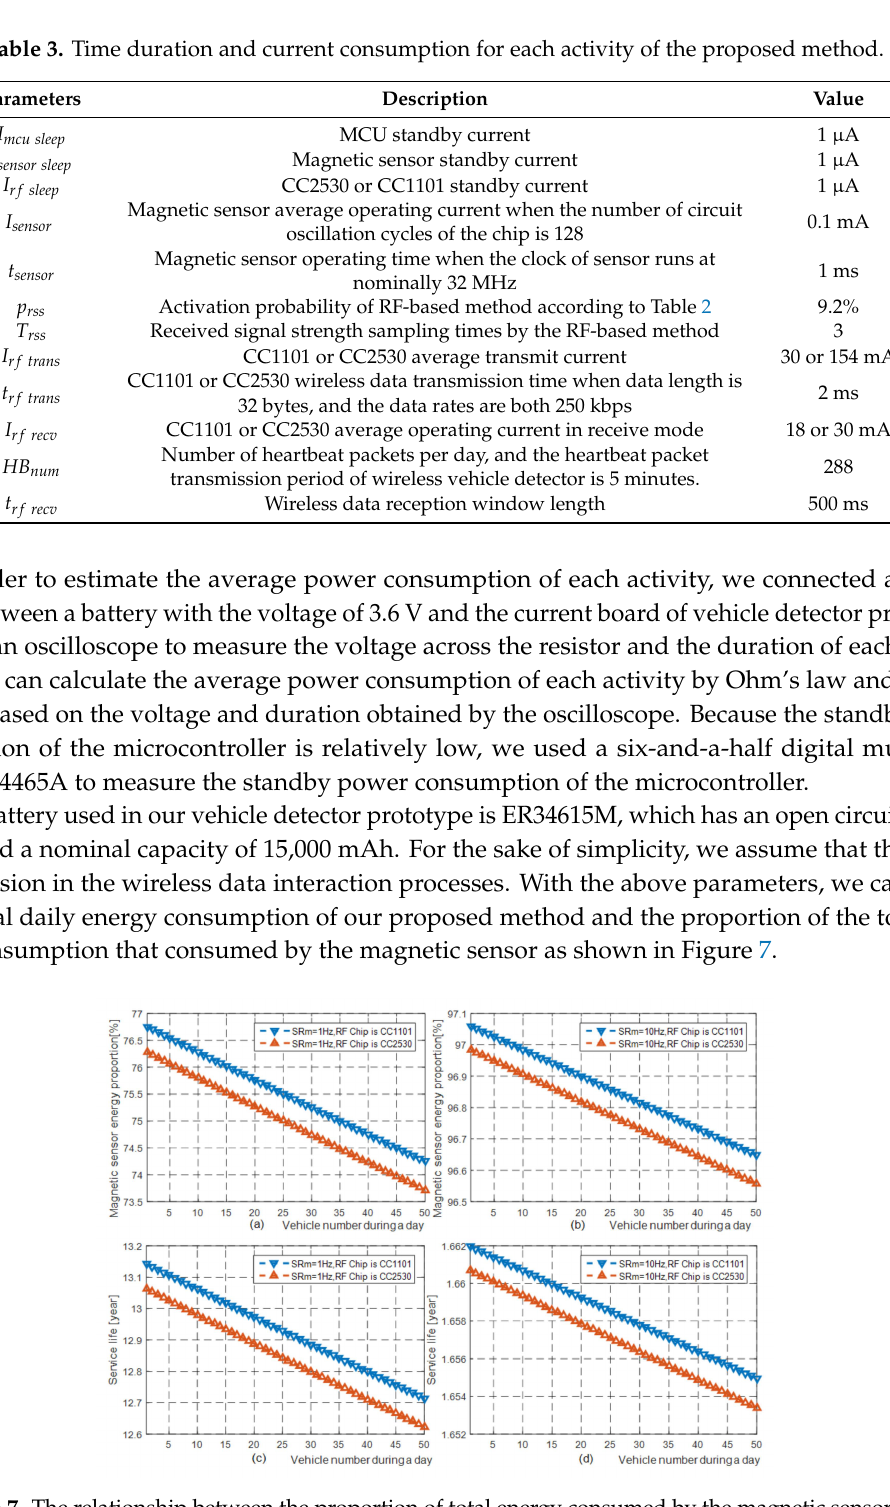
Figure 7. The relationship between the proportion of total energy consumed by the magnetic sensor and the number of vehicles detected per day, and the relationship between the WVD service years and the number of vehicles detected per day. ( a ) The proportion of the total energy consumed by the magnetic sensor in the two WVD prototypes with the radio frequency of 433 MHz and 2.4 GHz when the sampling rate of the magnetic sensor is 1 Hz. ( b ) The proportion of the total energy consumed by the magnetic sensor in the two WVD prototypes when the sampling rate of the magnetic sensor is 10 Hz. ( c ) The nominal serviceable years of the two prototypes when the sampling rate of the magnetic sensor is 1 Hz. ( d ) The nominal serviceable years of the two prototypes when the sampling rate of the magnetic sensor is 10